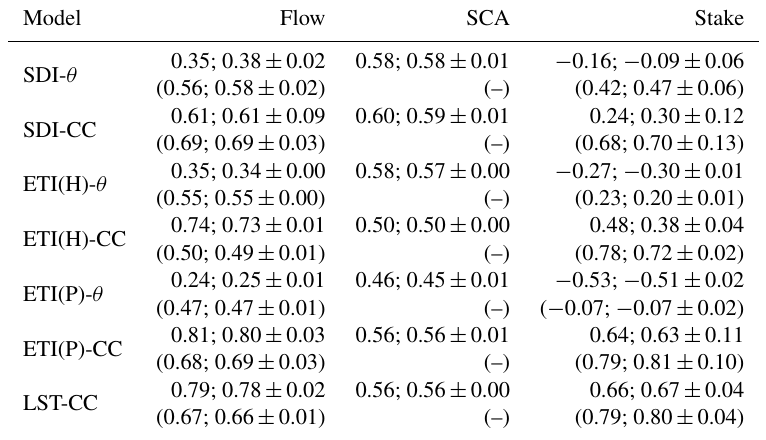
Table B4. Best model evaluation scores during validation for Wolverine; parameter sets are calibrated for Gulkana. The top row for each model is 1 minus the PBE score for the “SCA” columns and the KGE score for the “flow” and “stake” columns; the bottom row is the NSE